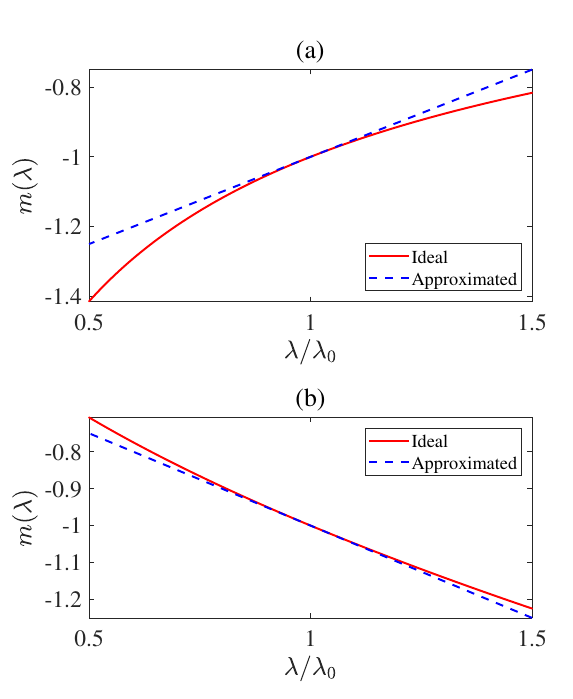
Figure 3. Numerically simulated performance of the transforma- tion systems for pursuing a (a) cross-spectrally pure (b) spectrally invariant output beam. Adapted from